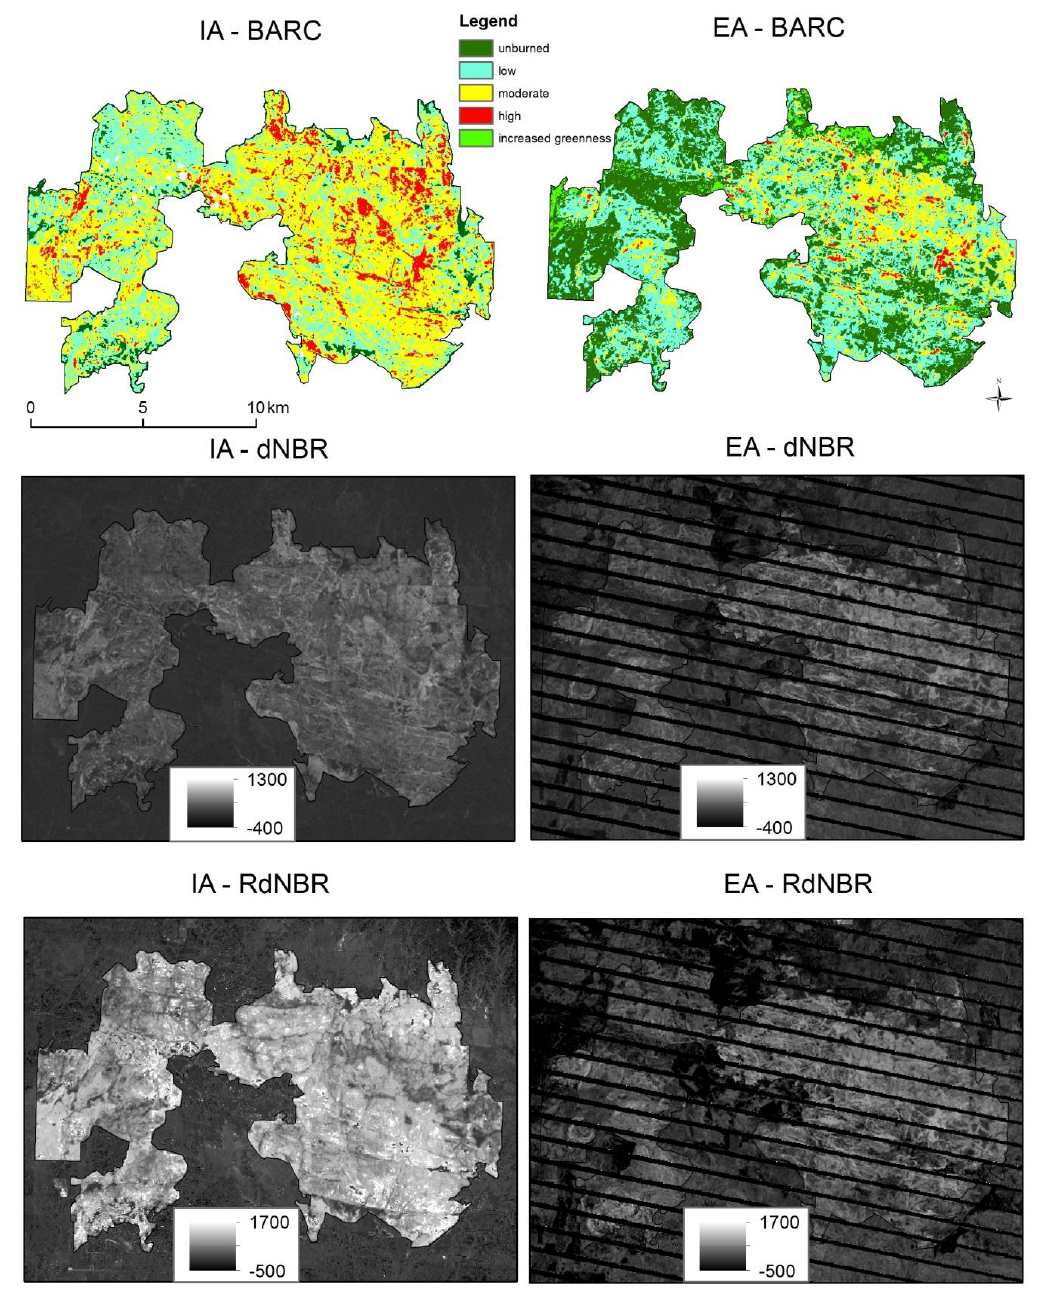
Figure 2. Maps of burn severity classification produced by the Burned Area Emergency Response (BAER) and MTBS projects for the Ferguson Fire. Thematically classified Burned Area Reflectance Classification (BARC) maps are produced for both a rapid initial assessment (IA) of burn severity within approximately one month following the fire and, for an extended assessment (EA) of burn severity, one growing season following the fire [39]. Thematically classified maps are produced using the dNBR (Equation 2) without the use of CBI plot data. See Table 1 for timing of the IA and EA. Stripes of “no data” resulting from a Landsat 7 scan line corrector (SLC) error were filled by MTBS analysts for the production of the thematically classified map, however, plot data analyzed by this study were not affected by the SLC